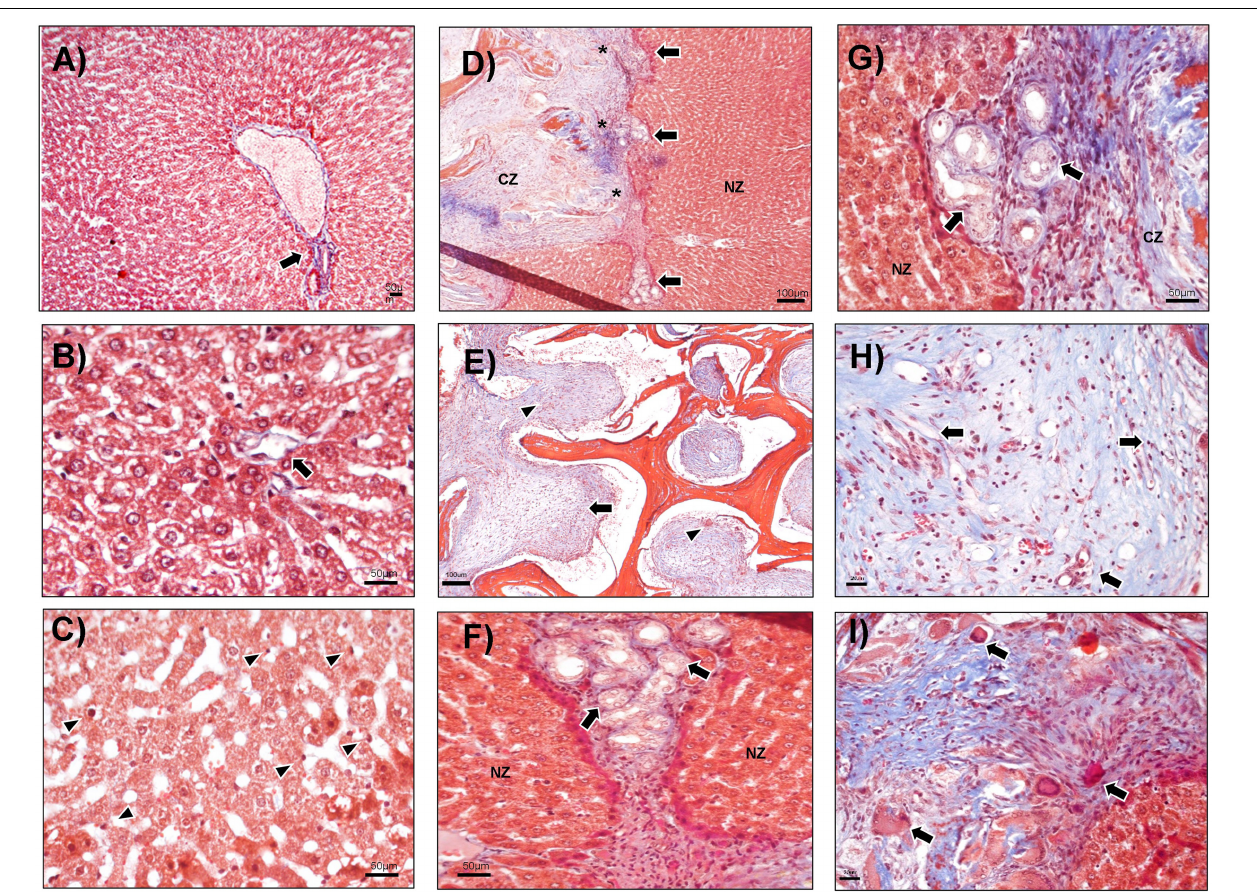
FIGURE 4 | Histological events at day 14 of evolution. (A) Representative sham animals showed portal triads (arrow) and normal parenchyma, 100 × . (B) PH group: central vein is shown (arrow), 400 × . (C) Basal fragments from animals at day 14 displayed the normal distribution of hepatocyte cords and Küpffer cells (arrowhead), 400 × . (D–I) PH + CMS. (D) CMS zone (CZ), ductular reaction shown (arrows), and multifocal areas of inflammation (asterisks). Normal zone (NZ) showed a typical parenchyma arrangement, 40 × . (E) The CZ showed CMS with great neovascularization (arrowheads) and fibroplasia (arrow) between CMS, 40 × . (F,G) At the